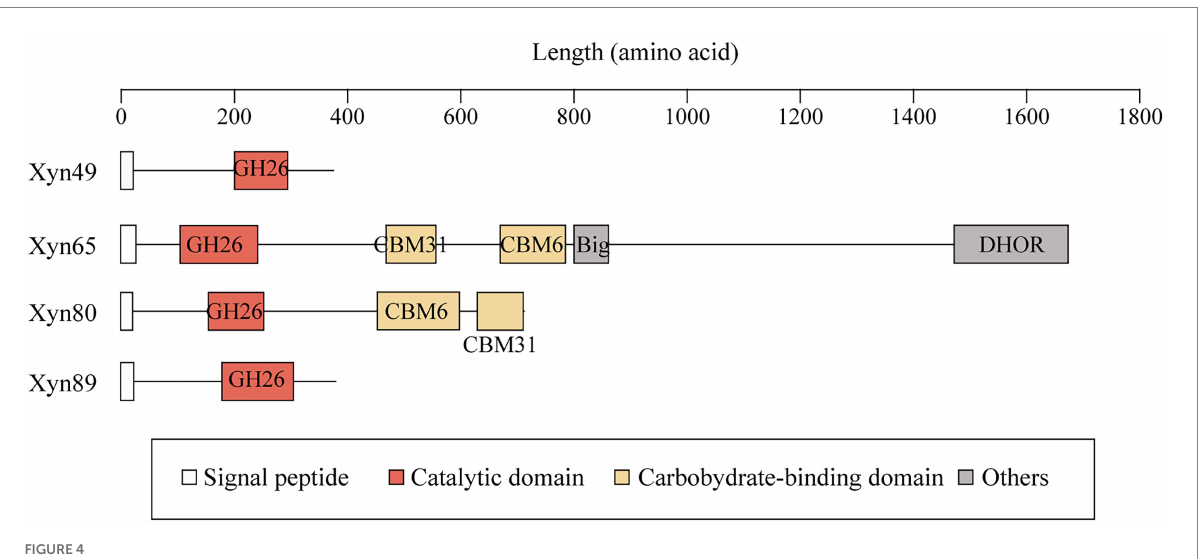
(Figure 6), suggesting the endo-action pattern of both enzymes on 1,3-xylan. Together, Xyn65 and Xyn80 are two strict endo-1,3- xylanases with similar enzymatic characteristics.